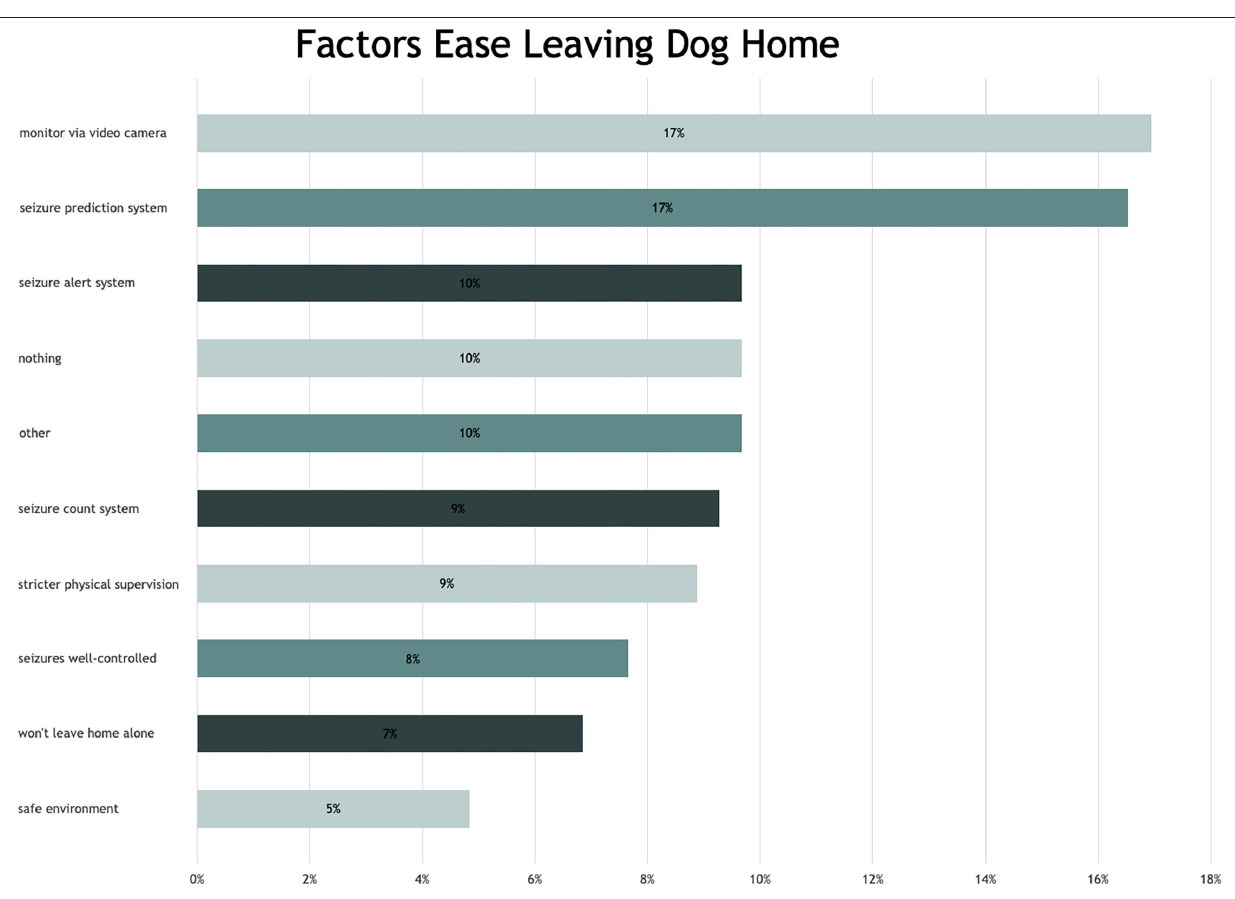
FIGURE 2 | Bar chart—factors that would ease leaving the dog home